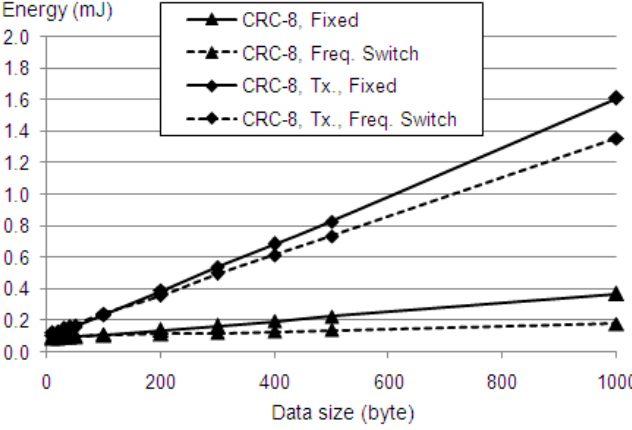
Figure 4 . Total energy consumption of CRC - 8 versus data sizes .